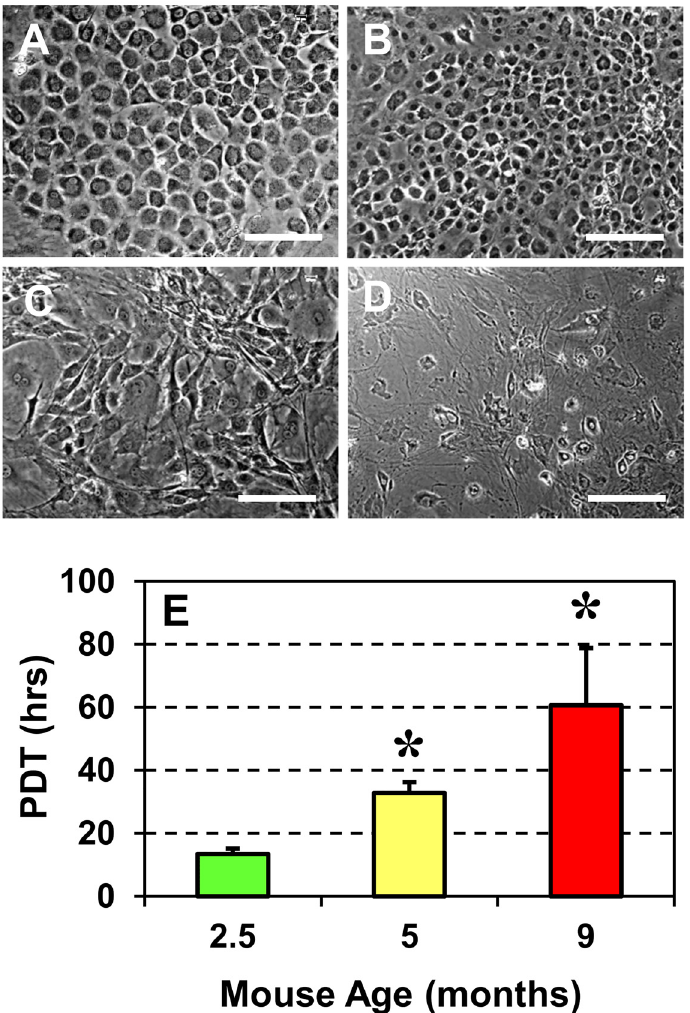
Fig 1. Morphology and proliferation of TSCs derived from young and aging mice. A . 2.5 months, B. 5 months, C. 9 months, and D. 24 months. With increasing mouse age, TSC morphology changed from cobblestone shape ( A , B ) to elongated/irregular shape ( C , D ). E. Proliferation of young and aging TSCs in culture measured by the population doubling time (PDT). The data shows that older the mice, greater the PDT or slower the TSC proliferation. Data represent the mean ± SD of three values. Statistical significance was calculated using the Student ’ s t -test ( * P < 0.05) with data from the 2.5-months old mice used as reference. Bar — 100 μ